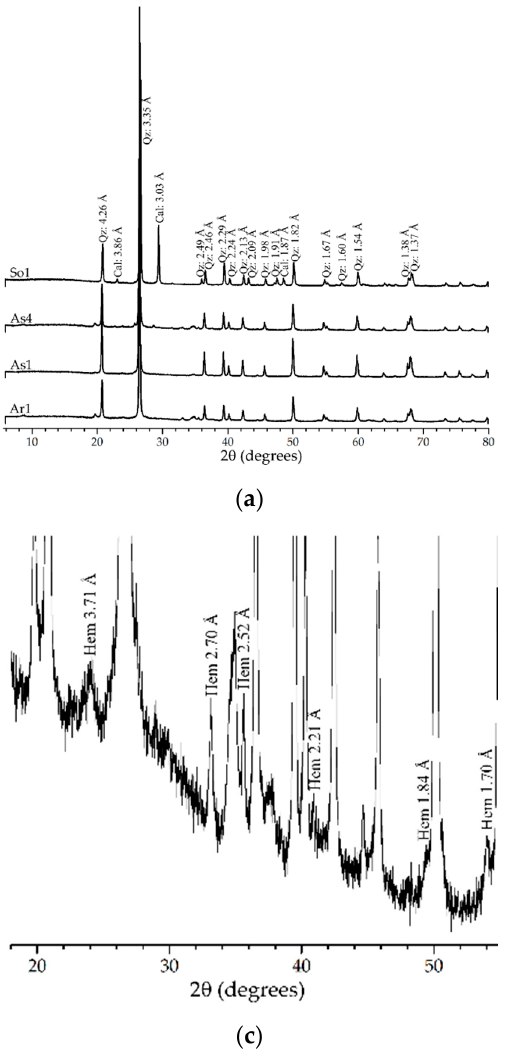
Figure 5. X-ray diffraction patterns of the chert samples from coastal outcrops showing reflections of quartz, Qz, and calcite, Cal, and calcite ( a ); orthoclase, Or, ( b ); moganite, Mog, ( c ) and fluorapatite, Ap, ( d ).